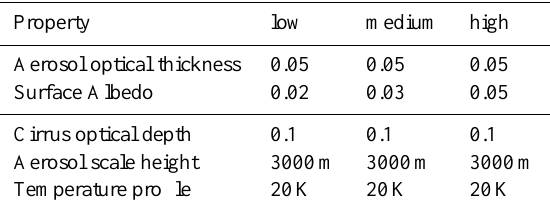
Table 2. Sensitivity simulations input parameter uncertainties in unit of standard deviation for each case (see Table